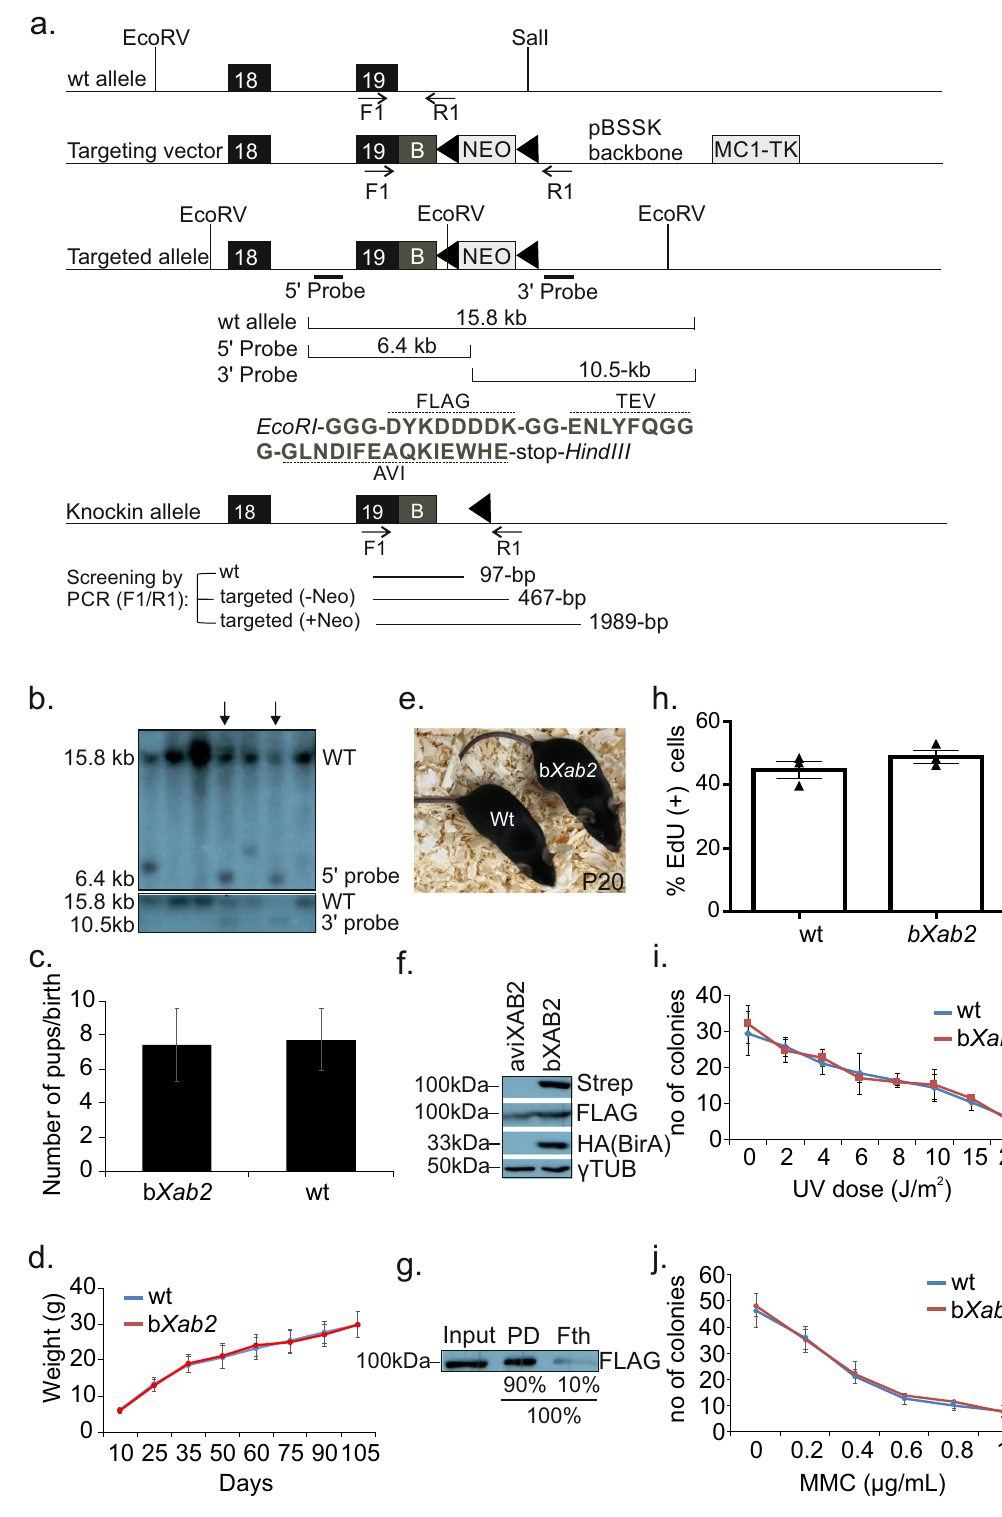
the proteome was separated by 1D SDS-PAGE (Fig. 2c) (~12 fractions) followed by in-gel digestion and peptides were analyzed with high-resolution liquid chromatography-tandem mass spec- trometry (nLC MS/MS) on a hybrid linear ion trap Orbitrap instrument. From three biological replicates, which comprised a total of 72 MS runs, we identi fi ed a total of 1167 proteins (Sup- plementary Data 1) with 636 proteins (54.49%) shared